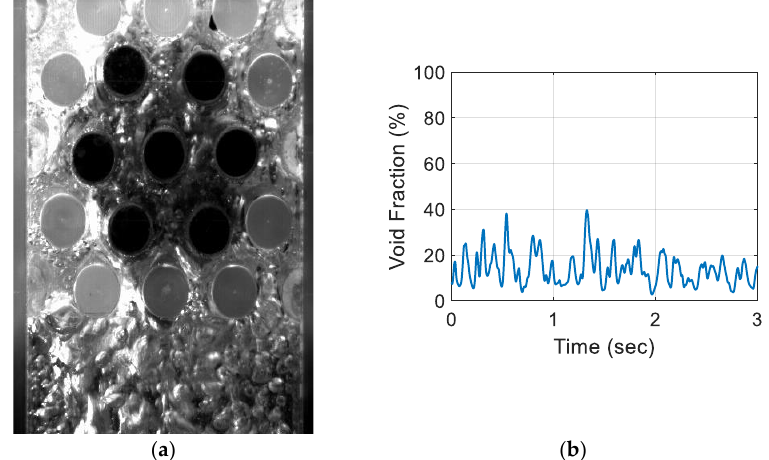
Figure 19. Experimental results for an air flow rate of 10 L/min: ( a ) flow visualization and ( b ) void fraction signal.